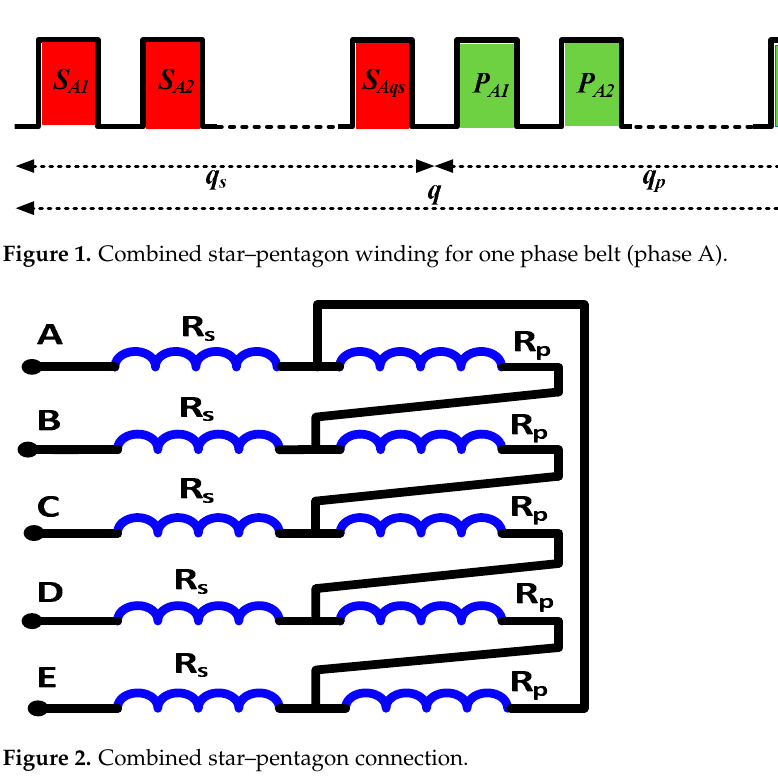
Figure 2. Combined star–pentagon connection.